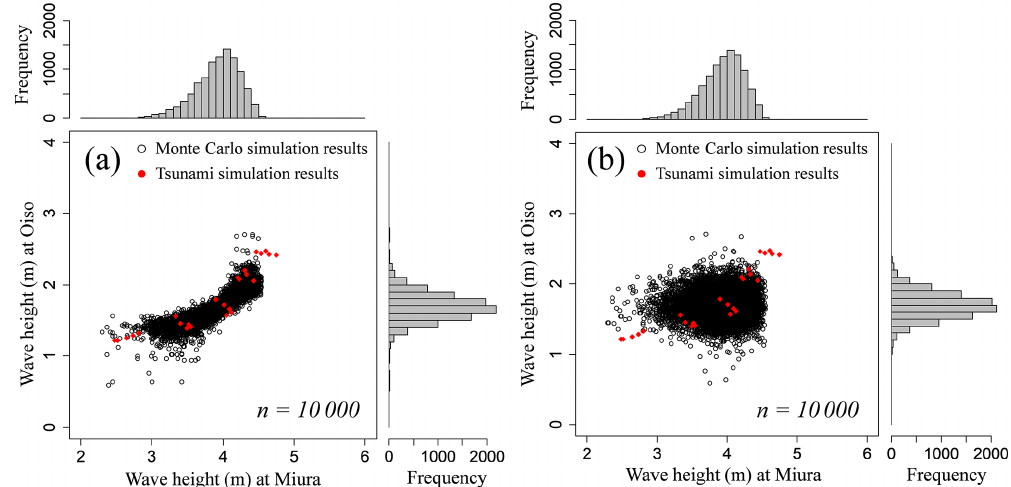
Figure 11. Monte Carlo simulation results for source 8. The black points denote the results with 10000 trials (a) considering and (b) not considering the spatial correlation of tsunami wave heights using the Frank copulas. The red points denote the results calculated from 25 cases of tsunami numerical simulation.